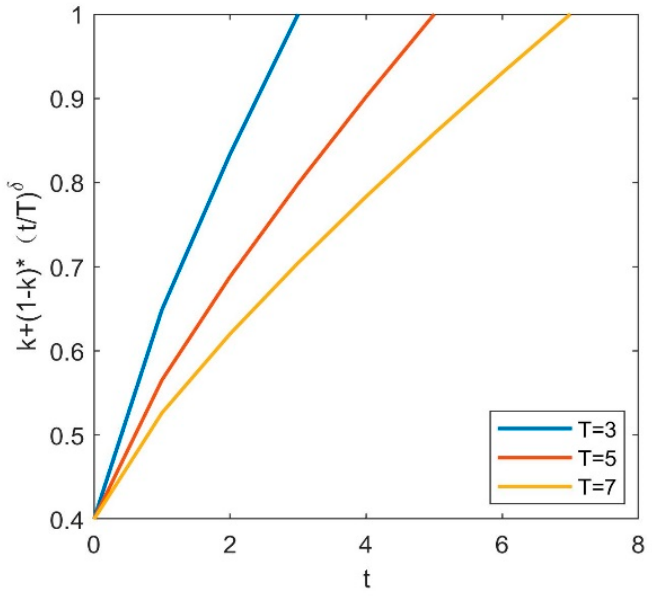
Figure 4. The influence of the number of quotations T on k + ( 1 − k ) ∗ ( t / T ) δ . We set k = 0.4 and examined the changes of k + ( 1 − k ) ∗ ( t / T ) δ under δ = 0.1, δ = 0.5, and δ = 0.9.